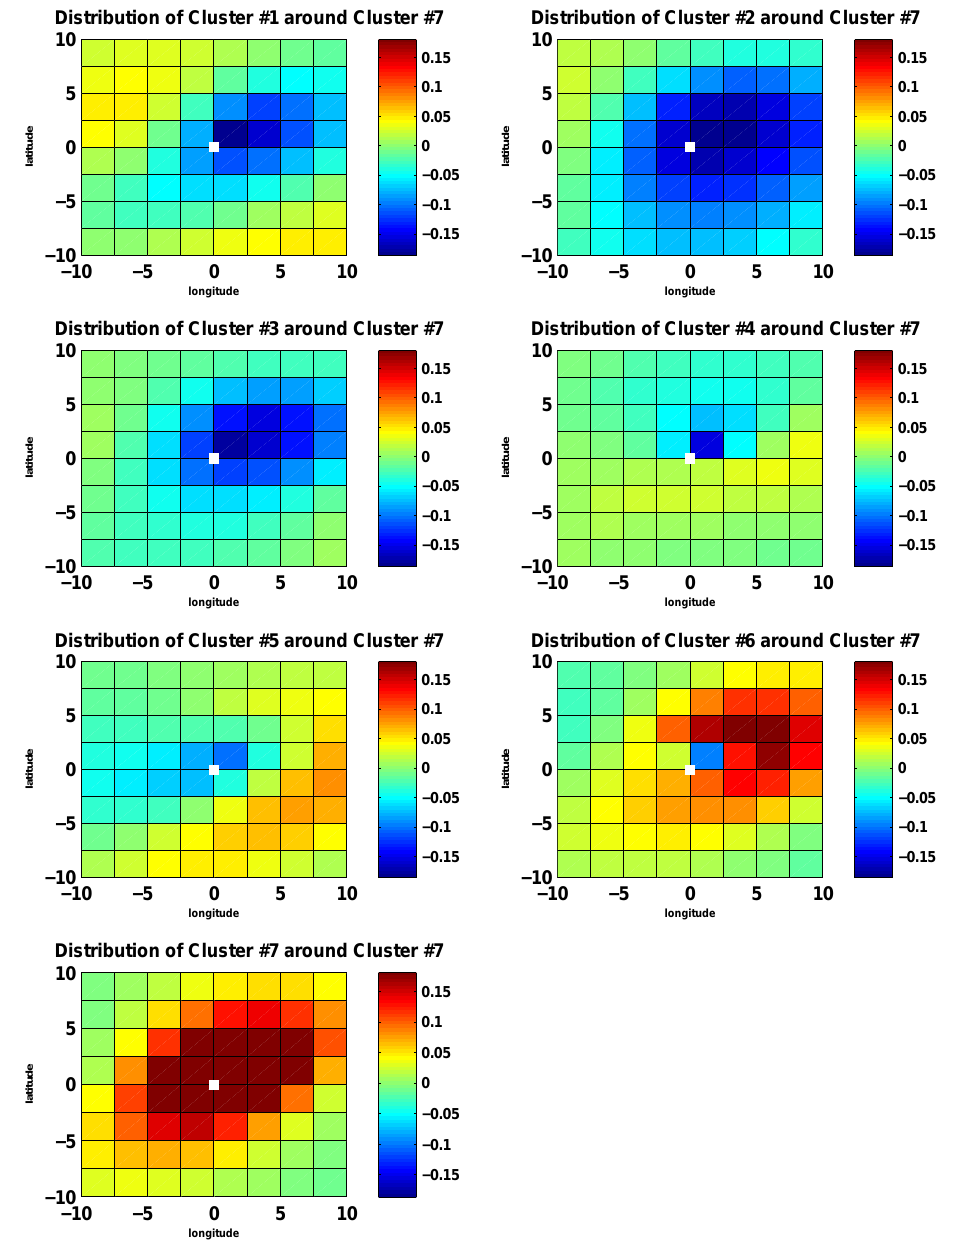
Fig. 7. Composite spatial distributions of the perturbation frequency of each cluster around a central grid box with the Strong Frontal